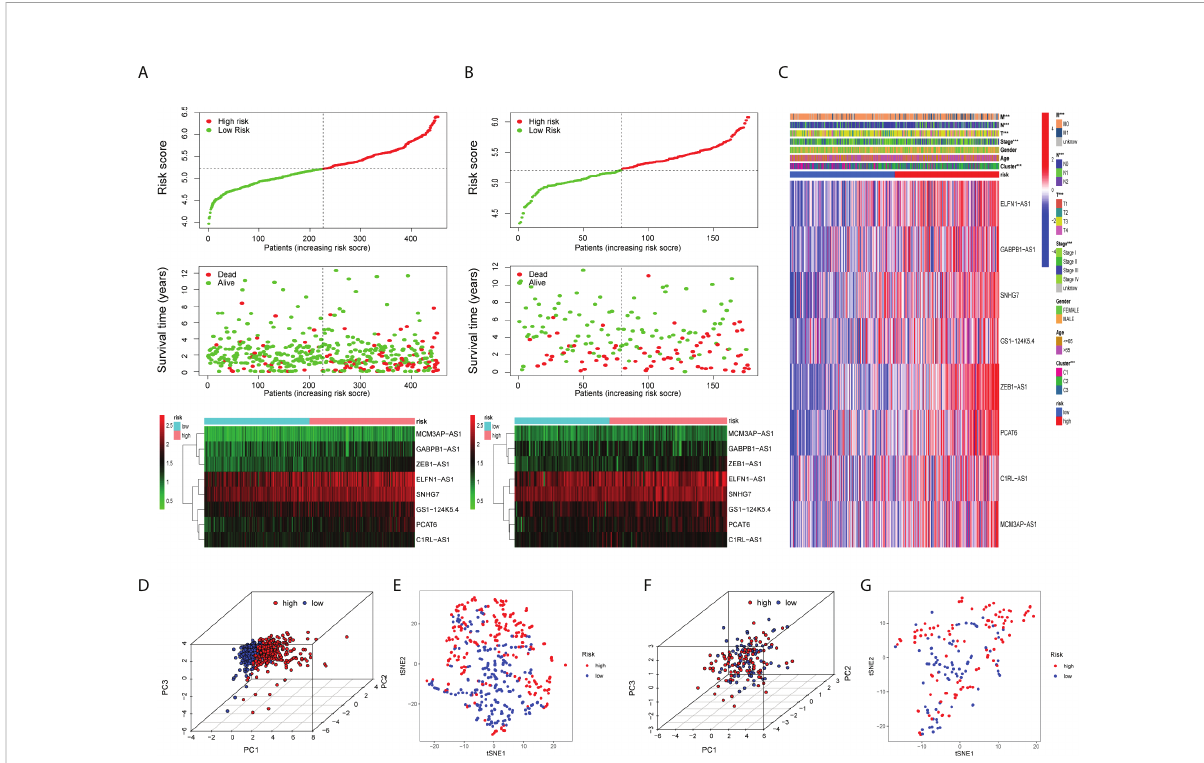
FIGURE 5 Validation of the prognostic risk model. Scatter plot revealing the risk score distribution of high risk and low risk and the relationship between survival time and risk score based on the training set (A) and test set (B) . Heat map displaying the differential expression of the eight prognostic m7G-related lncRNAs in the high- or low-risk group. (C) Heat map showing clinicopathological features (TMN stage, stage, age, gender) and differences in the expression of eight lncRNAs in the high- and low-risk groups. *P < 0.05, **P < 0.01, and ***P < 0.001. The 3D scatter plot of PCA results of the training set (D) and test set (F) .The t-SNE analysis of the training set (E) and test set (G)